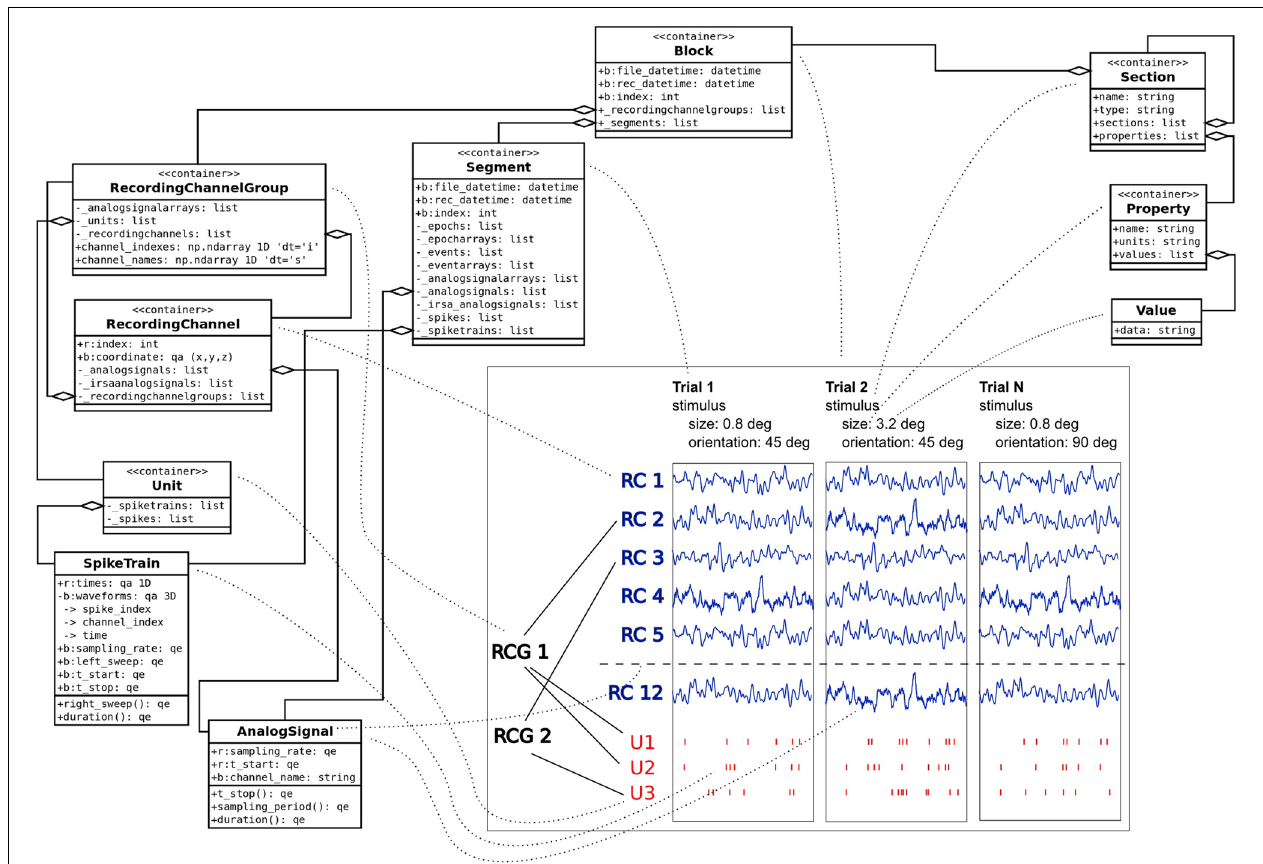
FIGURE 1 | Data model combining Neo and odML objects with key model classes used to describe experimental data and metadata. Traces in the center of the plot illustrate experimental time segments (Trials 1, 2, ... , N) containing LFP traces taken from corresponging channels (RC1, RC2, ... , RC12). Each time segment